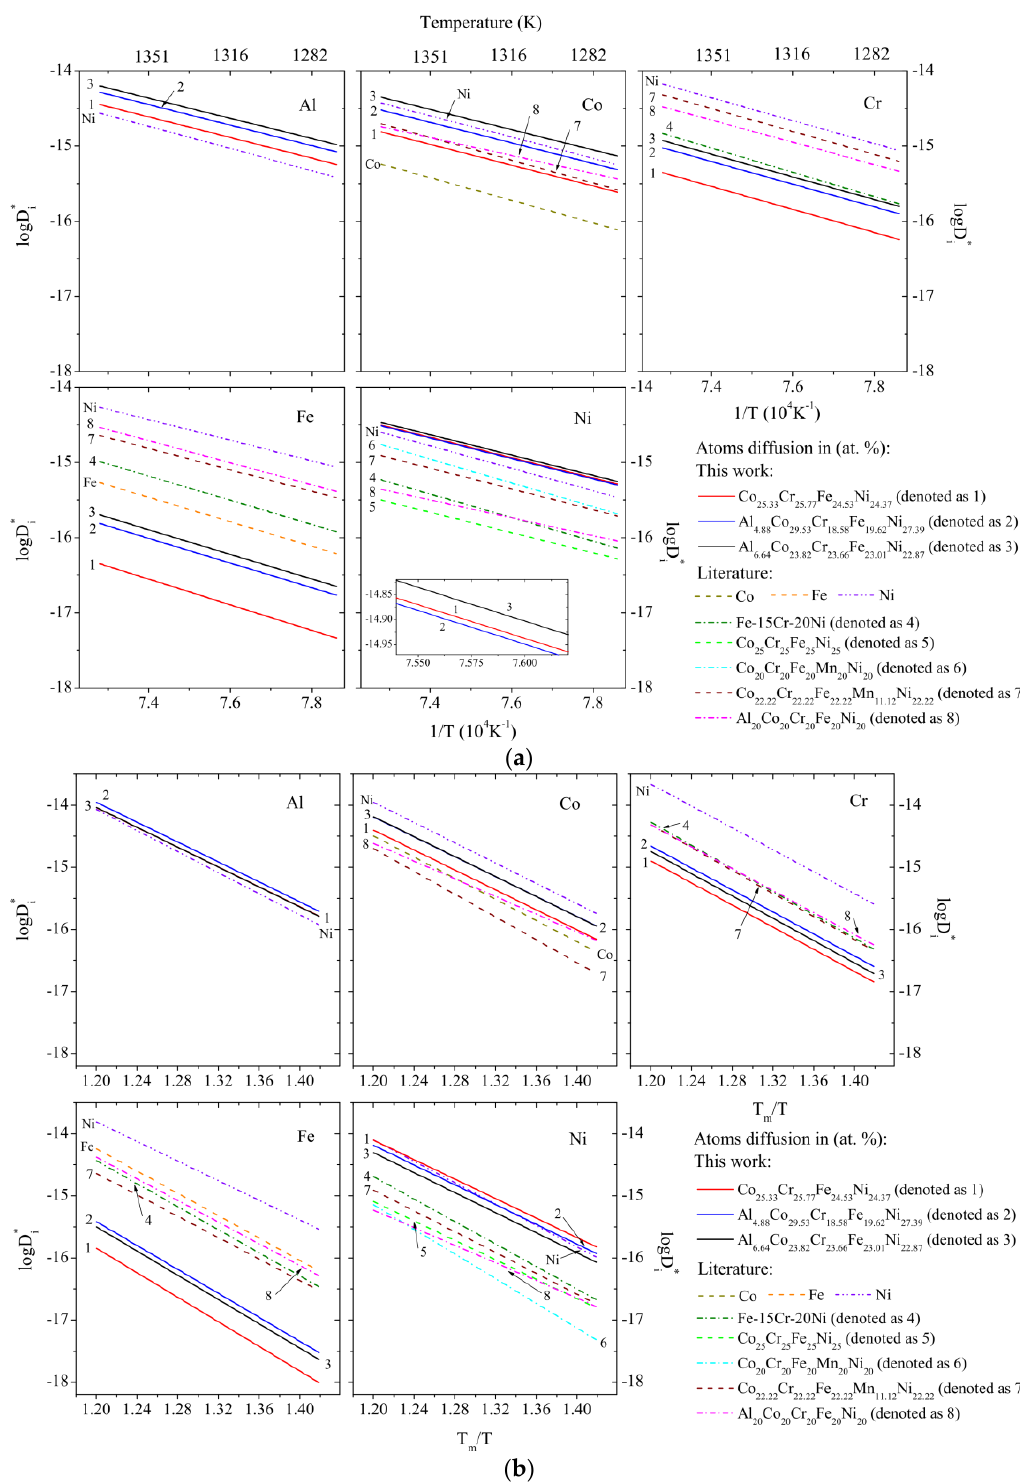
Figure 6. Tracer diffusivities estimated in present work and comparison with the literature data on diffusion in various fcc pure metals and alloys: pure Co [38], pure Fe [41], Al in Ni [37], Co in Ni [44], Cr in Ni [42], Fe in Ni [43], pure Ni [39], Fe–15Cr–20Ni [40], Co 25 Cr 25 Fe 25 Ni 25 [12], Co 20 Cr 20 Fe 20 Mn 20 Ni 20 [12], Co 22.22 Cr 22.22 Fe 22.22 Mn 11.12 Ni 22.22 [11], Al 20 Co 20 Cr 20 Fe 20 Ni 20 [11] plotted as a function of ( a ) the inverse absolute temperature and ( b ) the inverse homologous temperature.